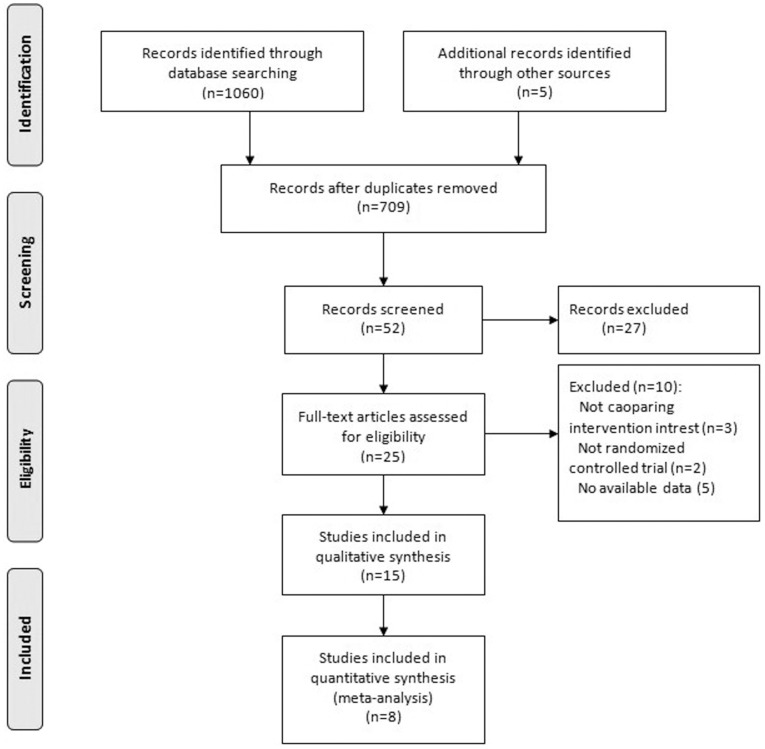
Identification of eligible studies.